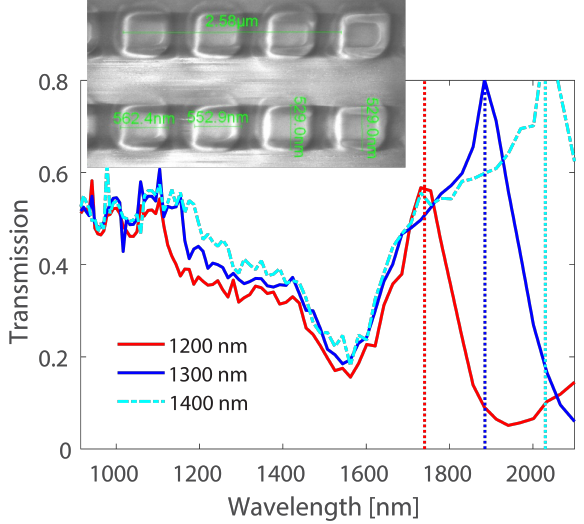
Figure 7. Experimental measurements for the transmission through nanoparticle array for d x = 1200, 1300, and 1400 nm. The vertical dotted lines denote the spectral position of the Rayleigh anomaly. Inset: SEM image of the array. The nanoparticle array is considered in the homogeneous (uniform) surrounding medium with a refractive index n = 1.45 (corresponds to glass). The cuboid nanoparticles are made of nickel with the dimensions a x = a y = 530 nm and a z = 300 nm. The incident plane wave is linearly polarized: it is normal to the array plane, propagates along the z -direction, and has an electric field along the y -direction. The two-dimensional infinite arrays have periods d x and d y = 1000 nm in the x - and y -directions, respectively. Reproduced from